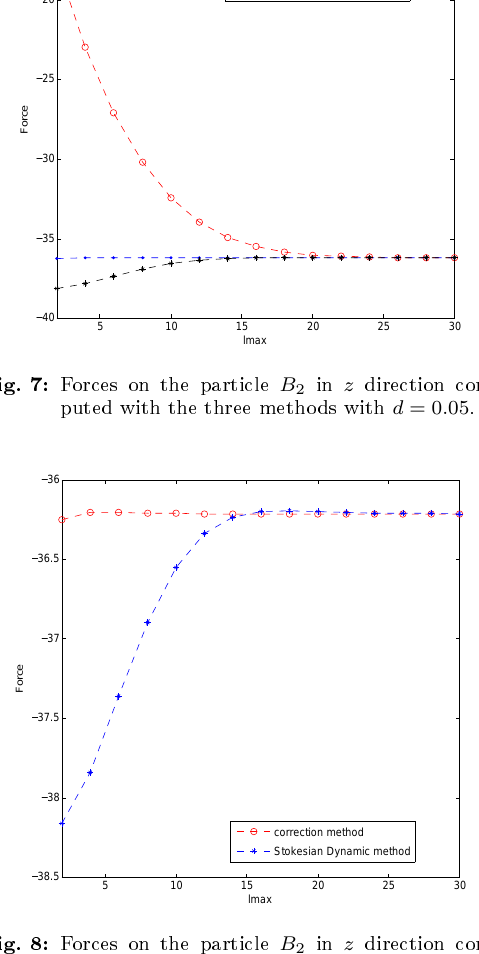
Fig. 8: Forces on the particle B 2 in z direction com- puted with the Stokesian Dynamics and the cor- rection method: B 1 ((cid:28)rst), B 2 (second), B 3 (third) and B 4 (fourth). d = 0 . 05